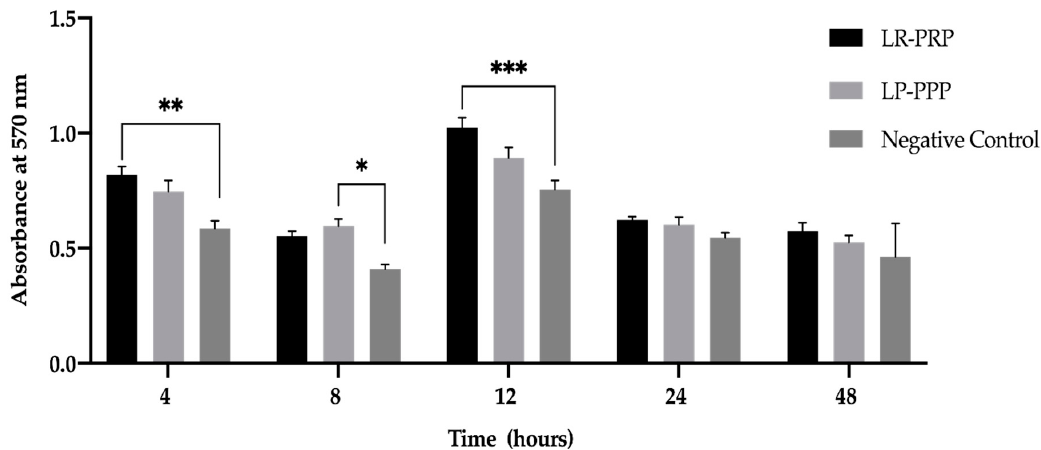
Figure 1. MTT Fibroblast Proliferation Assay. LR-PRP, LP-PPP, serum-free media (negative control)